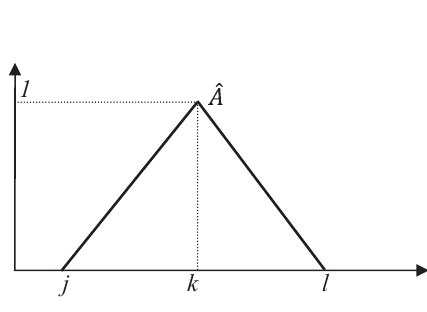
Figure 2. Triangular